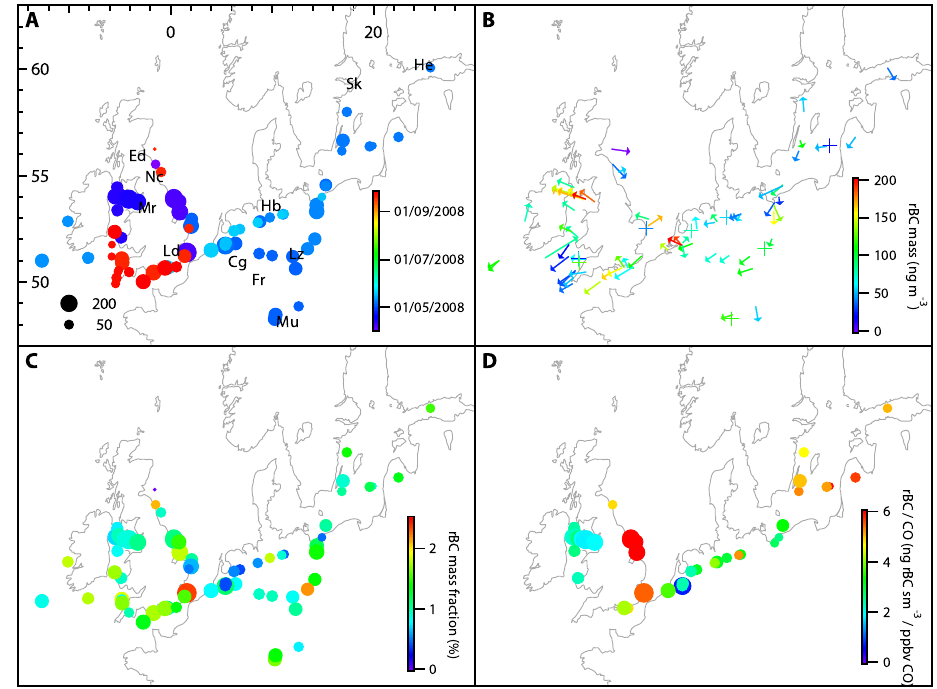
Fig. 3. Maps showing spatial distribution of refractory black carbon (rBC) averaged over straight and level runs (SLRs) below 3000 m. Points are sized by rBC mass concentrations and coloured by: (a) date/campaign; (b) rBC mass; (c) rBC mass fraction of fine aerosol mass (PCASP); and (d) rBC/excess carbon monoxide ratios. Points in panel b are shaded by rBC mass concentration and indicate the average wind speed and direction for each SLR. The longest wind speed arrow represents 15ms − 1 . Locations of selected cities are shown in panel a (Mr=Manchester, Ld=London, Nc=Newcastle, Br=Brussels, Fr=Frankfurt, Mu=Munich, Hb=Hamburg, Sk=Stockholm, and